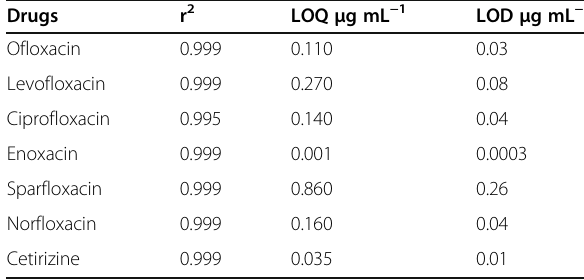
Table 2 Regression statistics and sensitivity of the